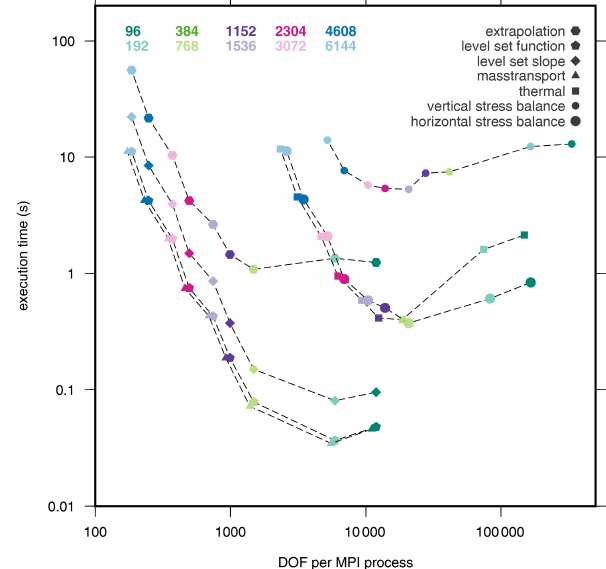
Figure 10. Execution time for matrix assembly for various modules. Symbols are representing the modules, while the colour is denoting the number of MPI processes.